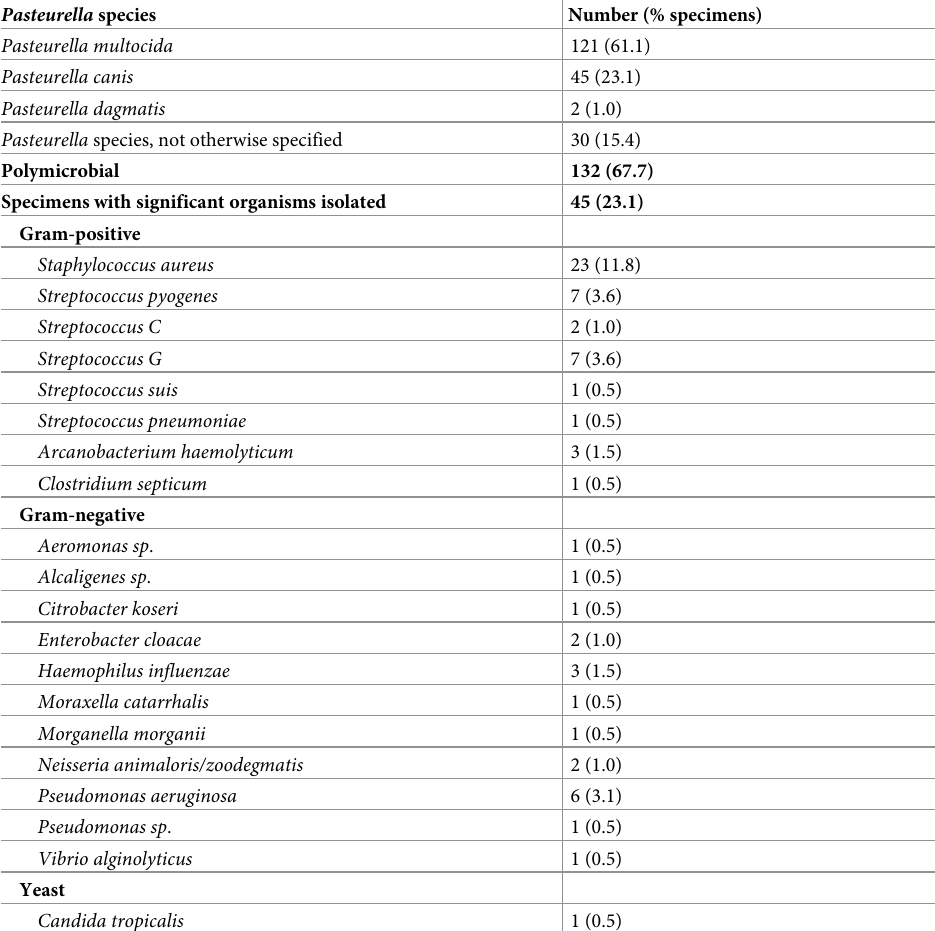
Table 4. Microbiology of Pasteurella spp.